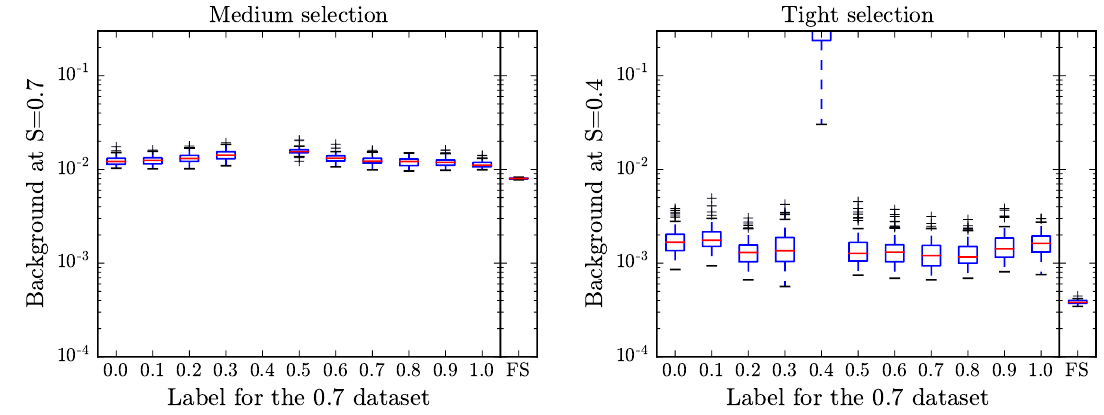
Figure 6 . Background e(cid:14)ciencies at (cid:12)xed values of signal